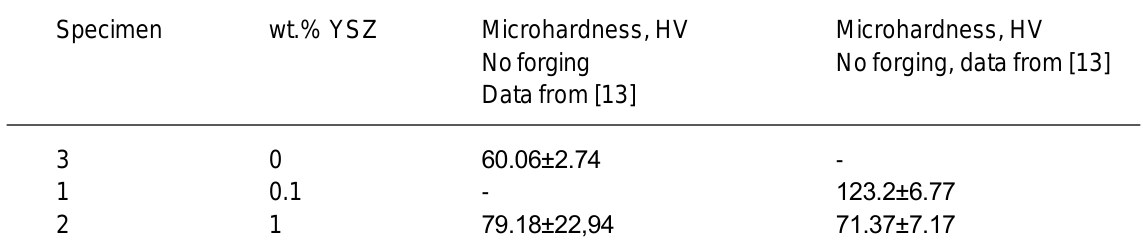
Table 1. Mechanical properties of Ni-YSZ composites before and after